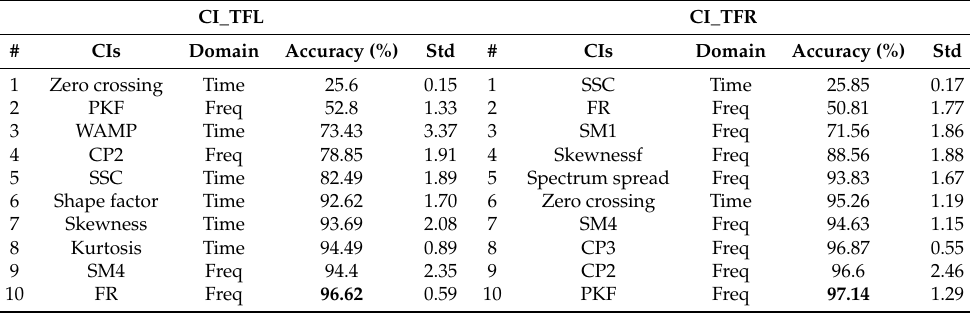
Table 7. Top 10 CIs and accuracies average over time and frequency